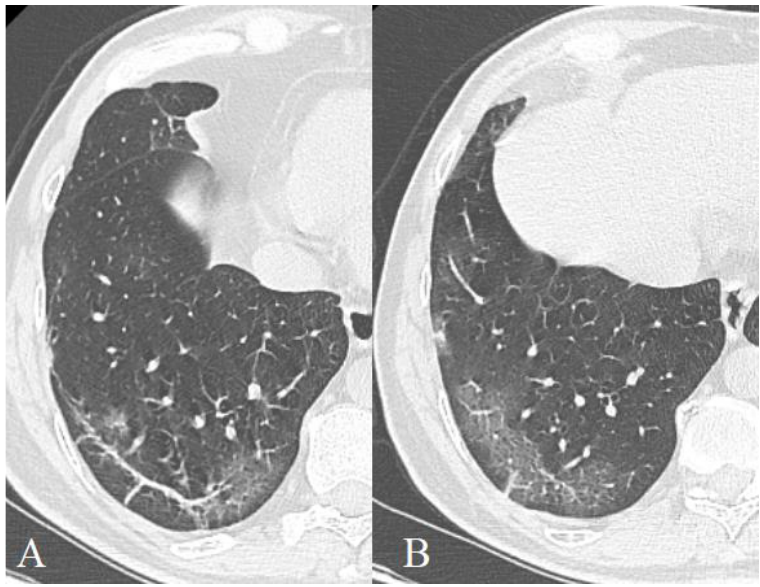
Figure 15. 56-year-old patient, subpleural linear bands ( A ) transform to focal ground-glass opaci- ties ( B